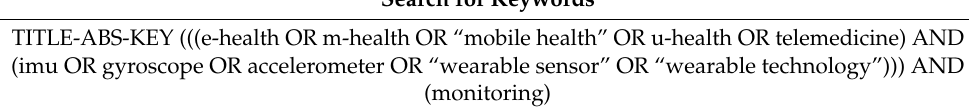
Search for Keywords